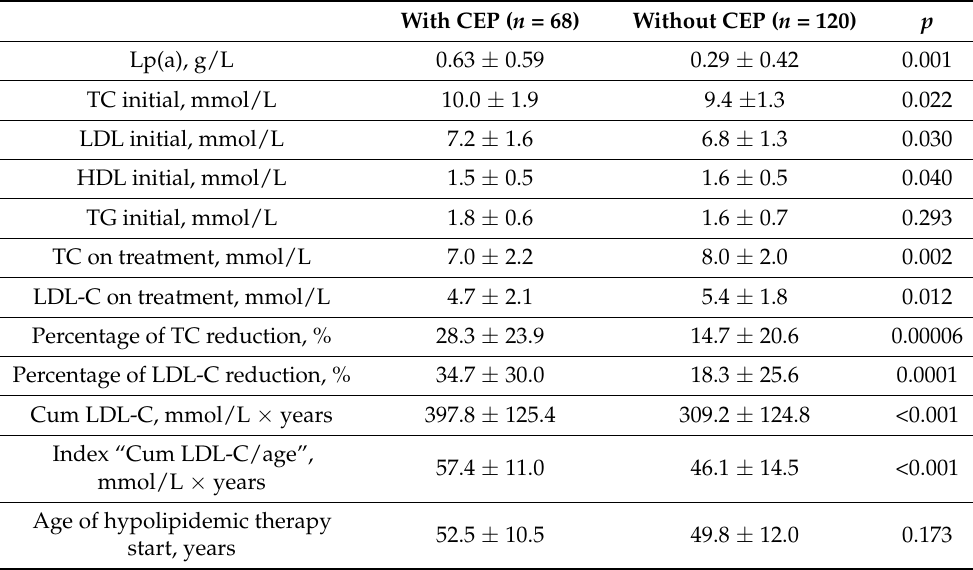
Table 8. Lipid risk factors in FH patients with combined end point